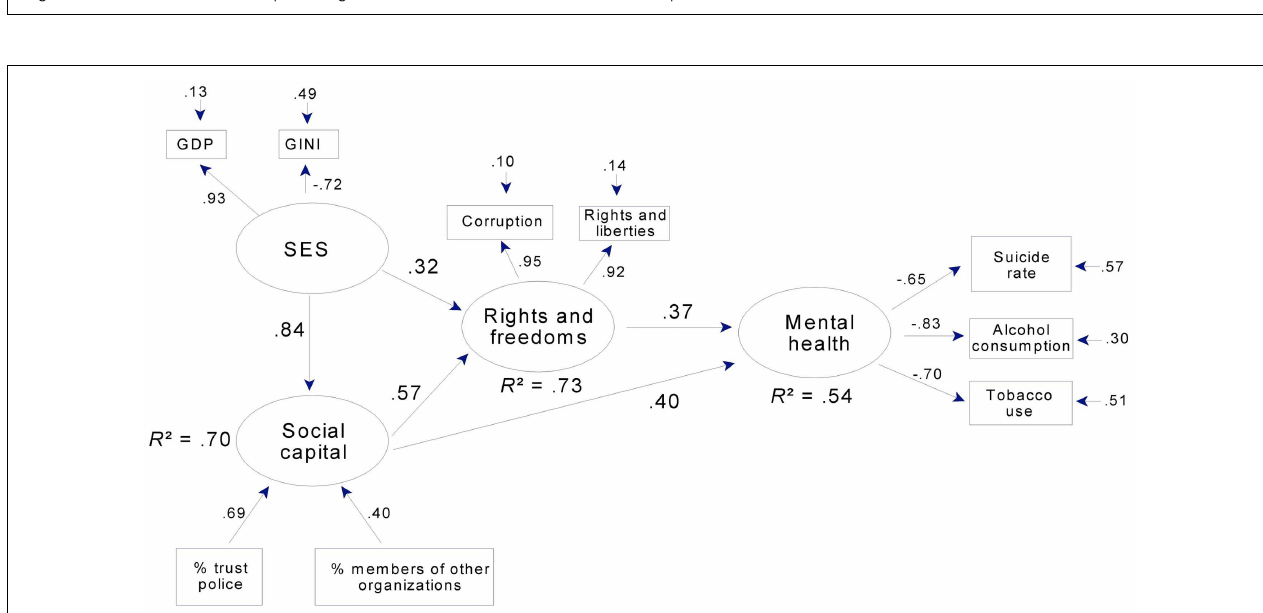
FIGURE 4 | Mental health, SES, and rights and freedoms: a path model for 34 countries. Note that corruption is reverse-scored, so that high scores = low levels of corruption. Rights and liberties = mean